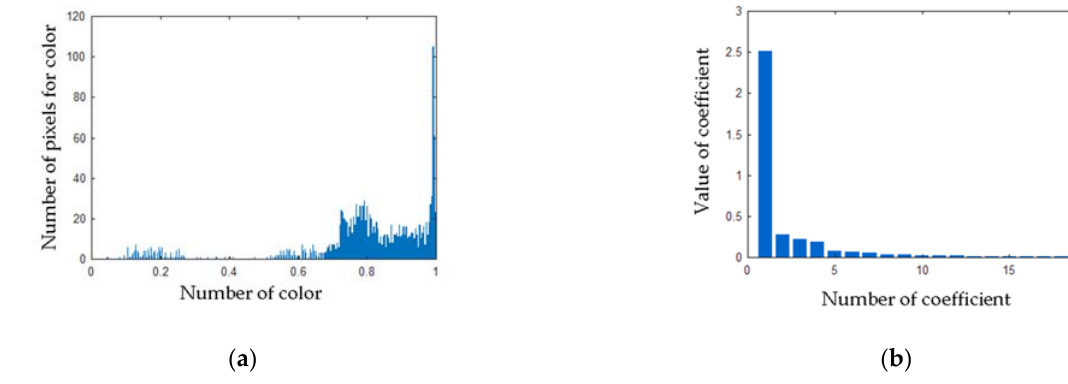
Figure 21. ( a ) Histogram of the matrix V for the thermal image of the angle grinder with 2 blocked air inlets ( b ) Values of PCA of the matrix V for the thermal image of the angle grinder with 2 blocked air inlets.